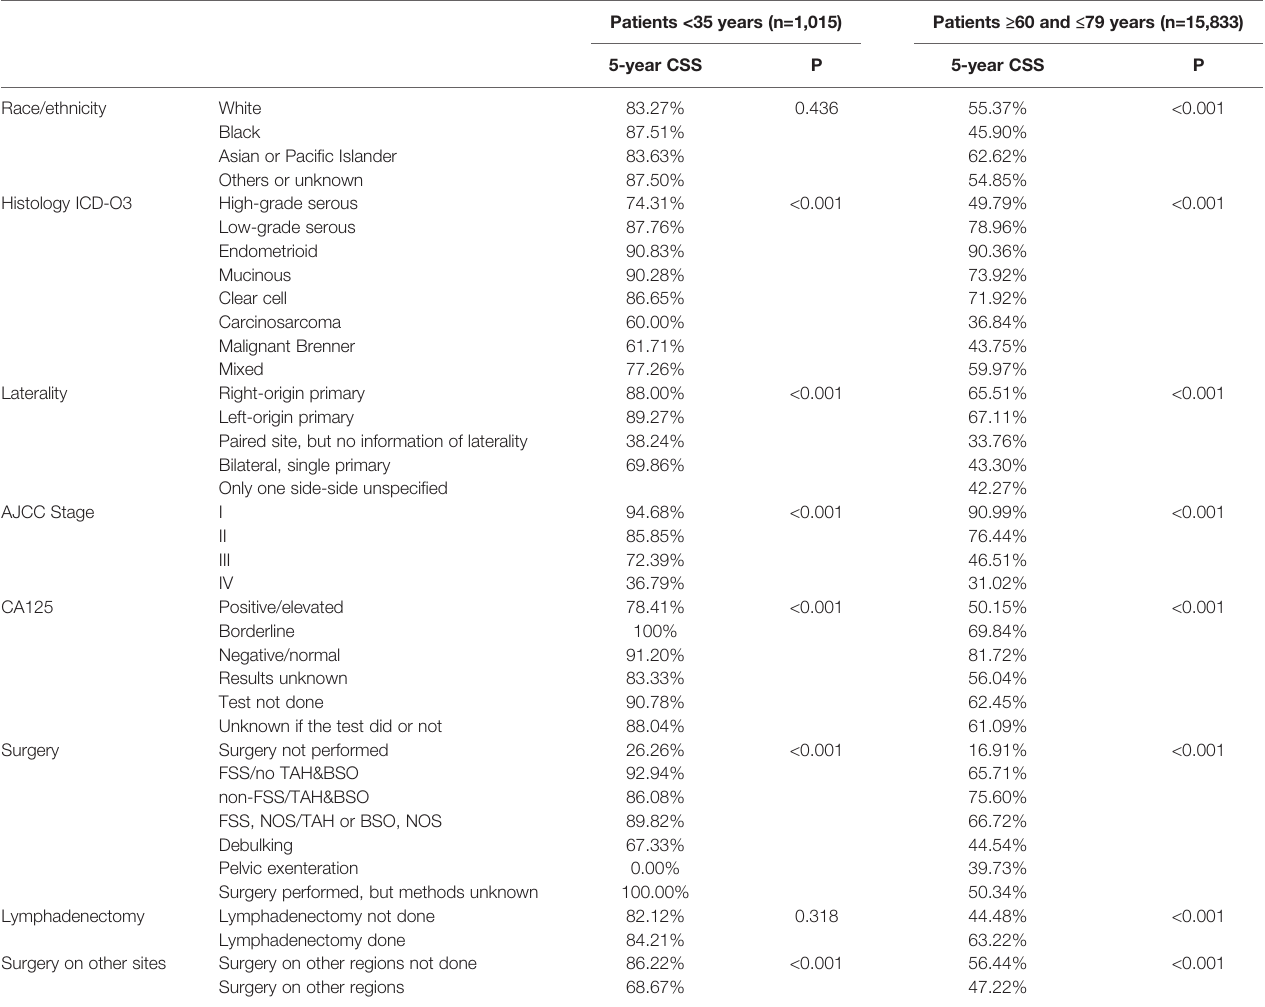
TABLE 3 | Univariate analysis by Cox regression for CSS in both young and old women group with epithelial ovarian cancer in 2004 – 2015, SEER 18